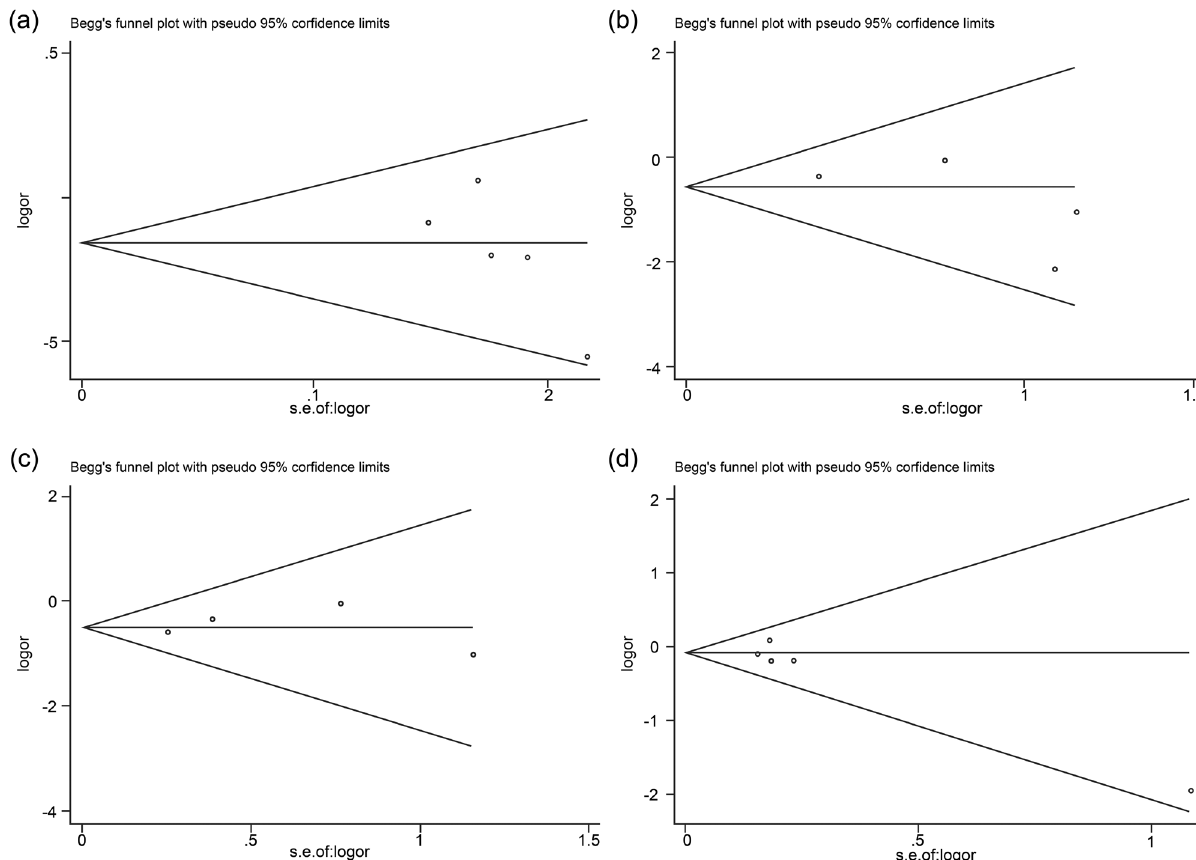
Figure 4: Funnel plots for IL - 6 gene − 572 G > C polymorphism and MI in overall analysis. ( a ) ( allelic model: C allele vs G allele ) , ( b ) ( additive model: C/C vs G/G ) , ( c ) ( recessive model: C/C vs G/C + G/G ) and ( d ) ( dominant model: C/C + G/C vs G/G )